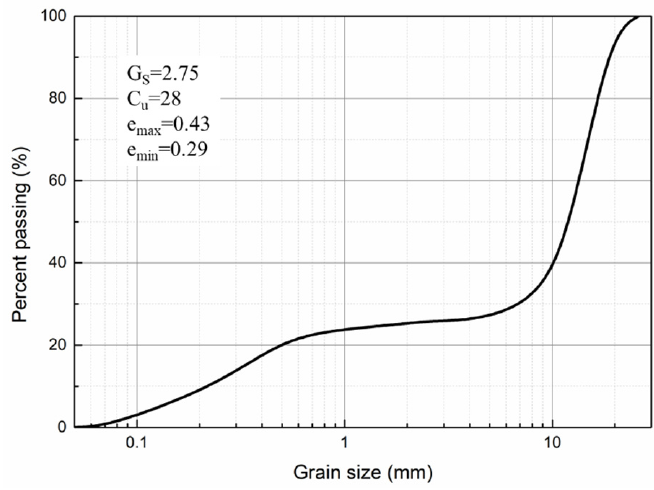
Figure 1. Particle size distribution of granular materials.